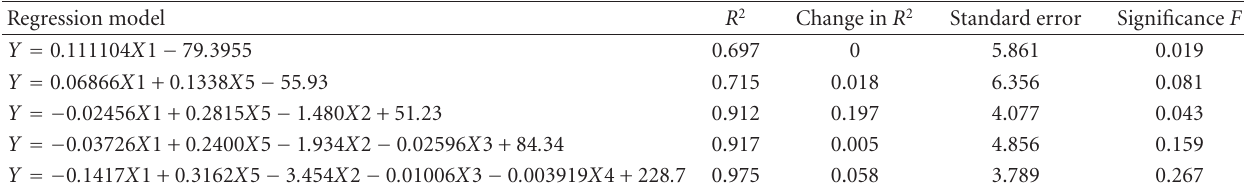
Table 5: Multiple stepwise regression of dead tree biomass (2011) at the stand level versus five stand characteristics in 2008 ( X 1: altitude; X 2: slope angle; X 3: slope aspect; X 4: stand density; X 5: AGB in 2008).